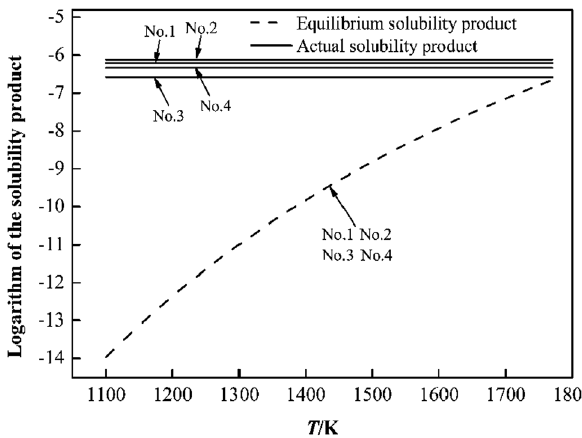
Figure 10: Logarithm of the solubility product as a function of temperature for MnS in the solid